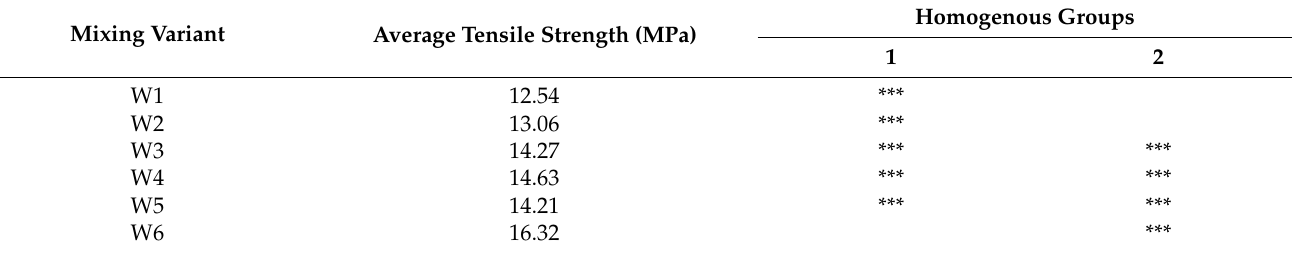
Table A4. Results of Tukey’s post hoc (HSD) tensile strength test for E57/Z-1/ZR2/100:10:5 composition. Mixing Variant